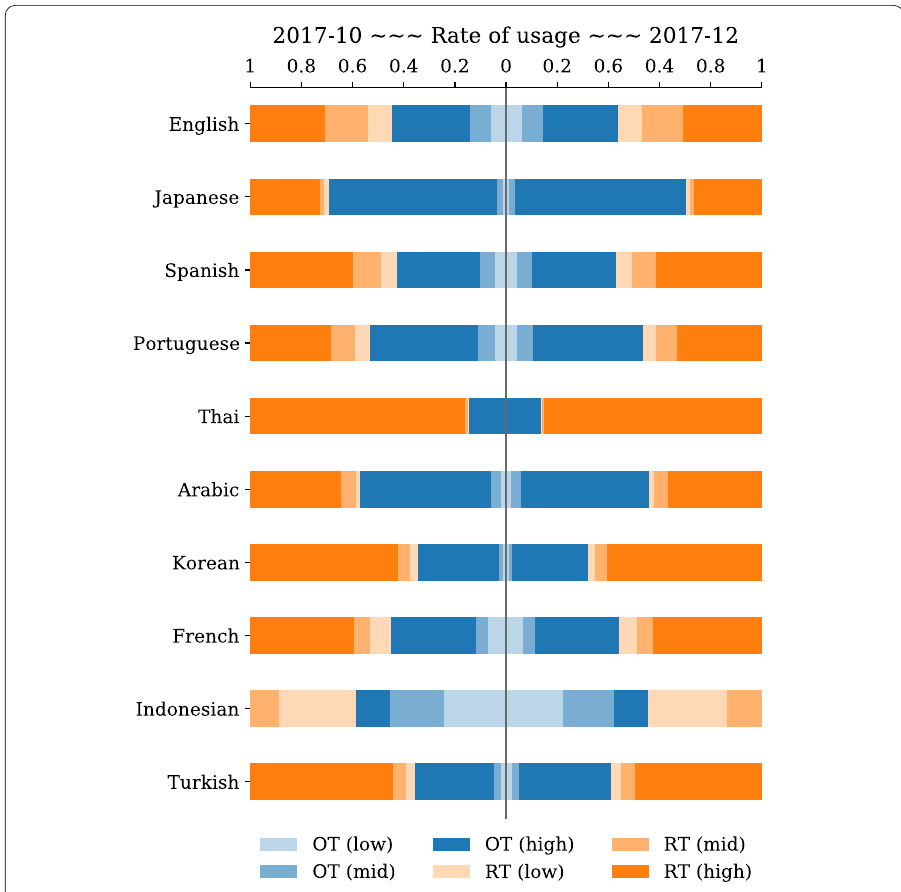
Figure 12 Confidence scores of the FastText-LID neural network predictions for the month before and after the shift to 280 characters. We categorize messages into four classes based on the confidence scores we get from FastText-LID’s neural network. Predictions with confidence scores below 0.25 are labeled as Undefined (und). Messages with scores greater or equal to 0.25 but less than 0.5 are flagged as predictions with low confidence (low). Predictions that have scores in the range [0.5,0.75) are considered moderate (mid), and messages with higher scores are labeled as predictions with high confidence (high). We note a symmetry indicating that the shift did not have a large impact on the network’s predictions across organic and retweeted